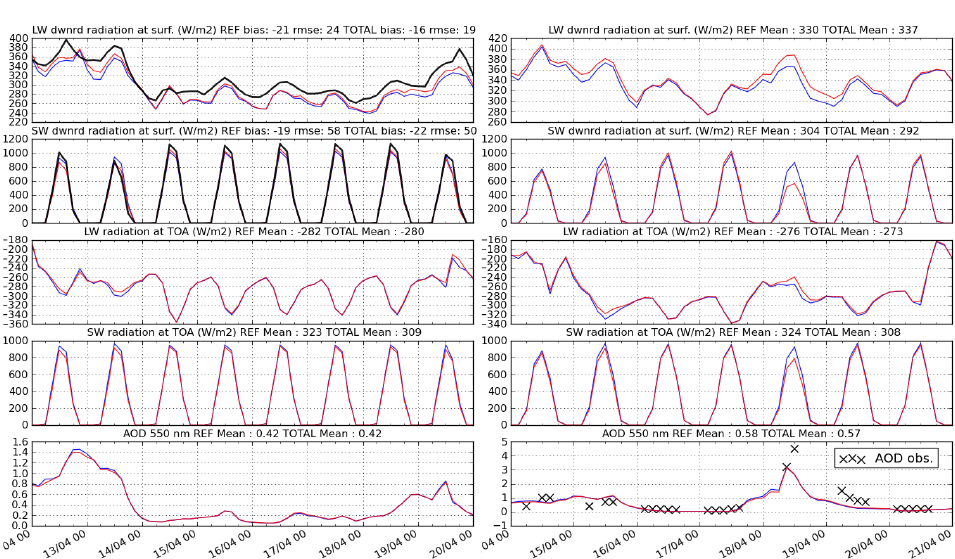
Figure 5. Depicted are 3–24h forecasts and observations (when available, in black) of downward short-wave and long-wave radiation fluxes at the surface and 550nm AOD at Tamanrasset (left) and Cairo (right). REF experiment is in blue, TOTAL is in red and observations are in black. The bias and root-mean-square error (RMSE) of forecasts for observations for the whole period are also indicated on top. By convention, fluxes from the surface are negative and fluxes towards the surface are